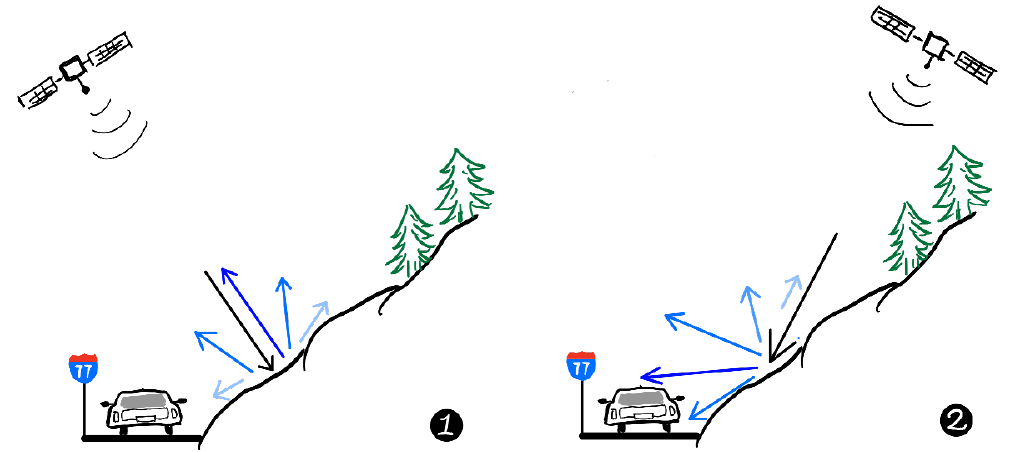
Figure 4. The relationship between the incidence angle, slope in the range direction and the backscatter of the reflected radar signal. ( left ) When the line of sight (LoS) is almost orthogonal to the slope, the backscatter signal received by satellite will reach maximum. ( right ) When there is a very narrow-angle between the LoS and the slope, the signal will mostly bounce away and there will be very little signal from the target received by the satellite. Note that orthogonality also implied the strongest geometric distortion, and the selection of the incidence angle should balance the SNR against the geometric distortion.